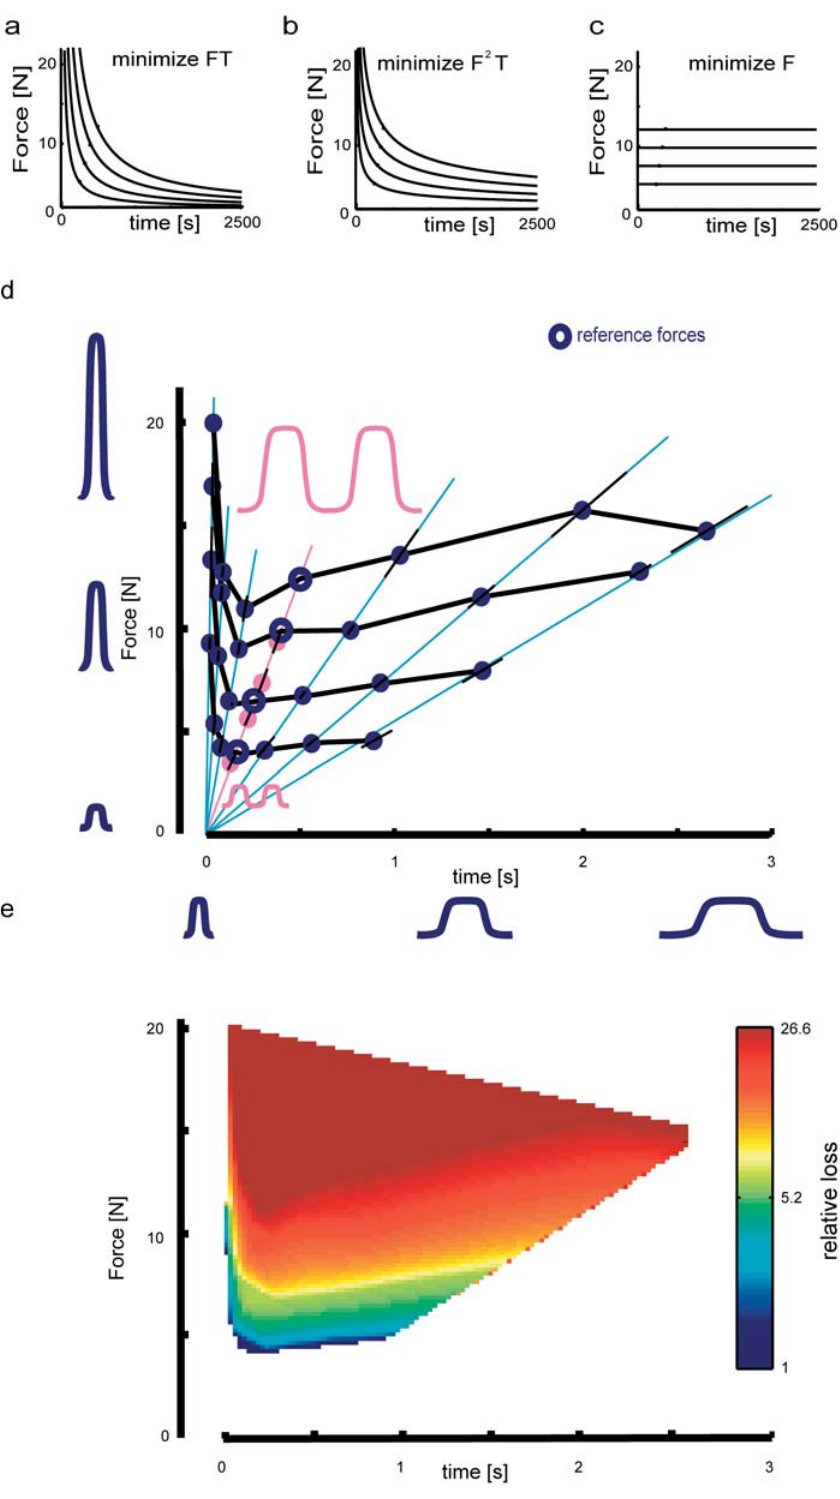
hump experiments leads to an a of 1.1 6 0.15 (mean 6 SEM over subjects). This a , when fit to the data from all the subjects for each of the four lines, is approximately constant (1.2, 1.0, 0.9, 0.9). The shape of the loss function is highly conserved over the set of subjects. In particular, the effect that indifference curves increase for both very short and long durations is found over the set of subjects.